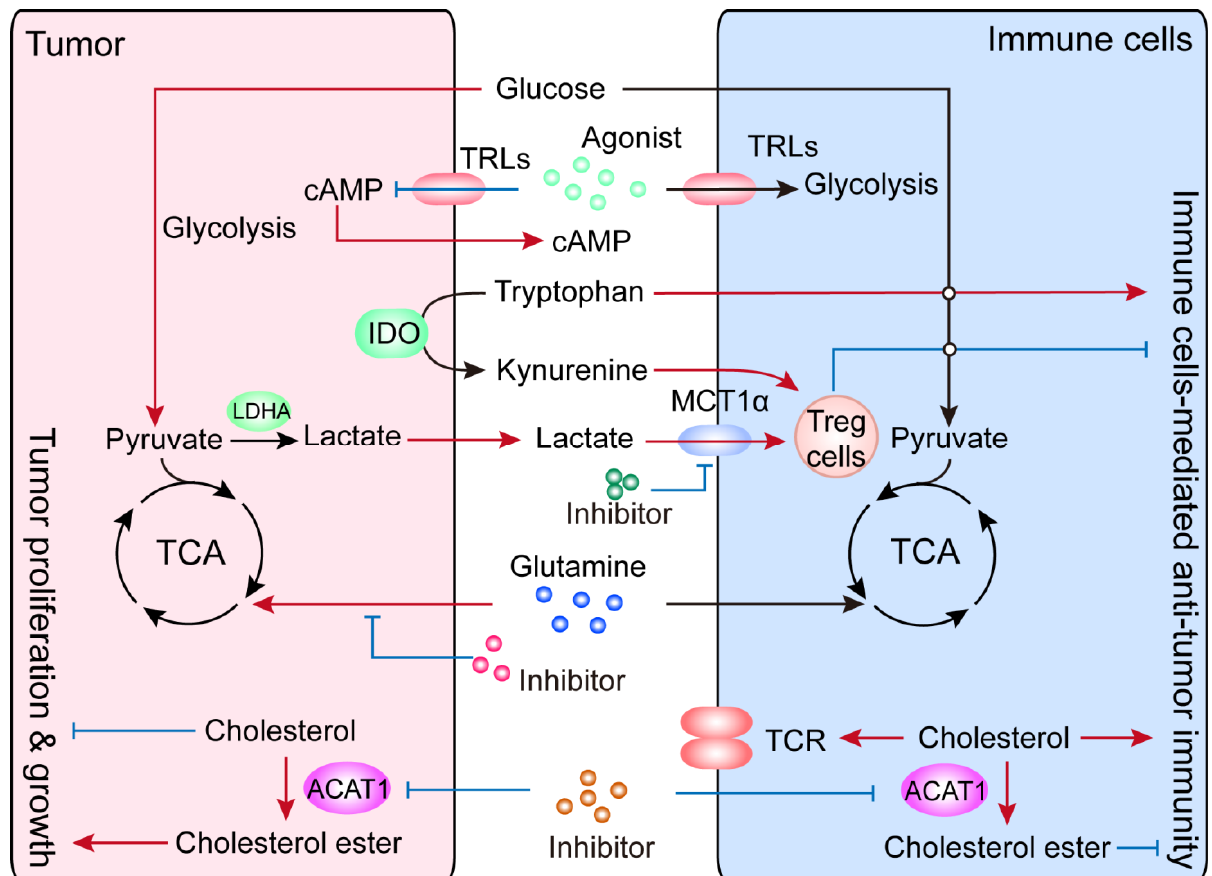
Figure 6. An overview of potentially innovative strategies to improve cancer immunotherapy through the manipulation of metabolic reprogramming. Glutamine, ATAC1, IDO, lactate and TLRs might be considered novel “metabolic checkpoints”, the targeting of which could potentially enhance the function of immune cells to better achieve anti-tumor effects. The red arrows indicate enhanced metabolic processes or functions, the blue arrows indicate suppressed processes, and the black arrows and text indicate baseline activities.